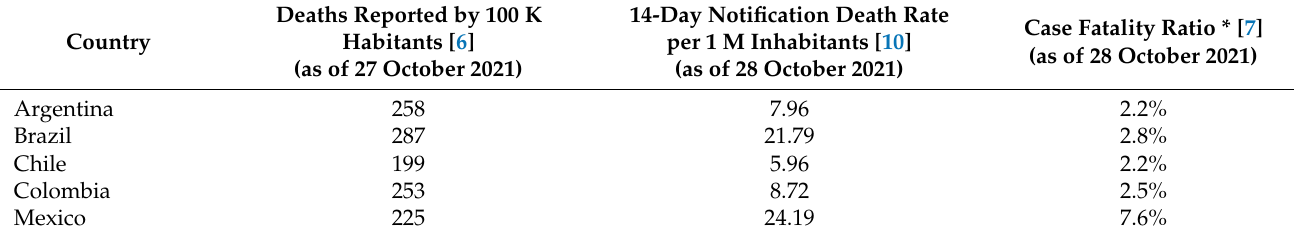
Table 1. Impact of the pandemic in focus countries: Argentina, Brazil, Chile, Colombia, and Mexico. Deaths Reported by 100 Country